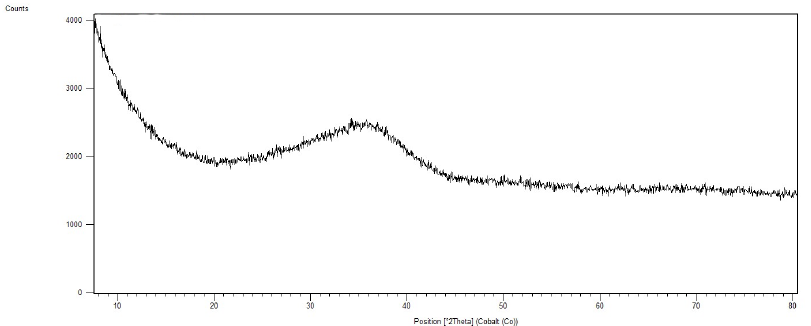
Figure 12: XRPD pattern of sample MT-OS1-O1. Note that no peaks, due to crystalline phases, are visible.